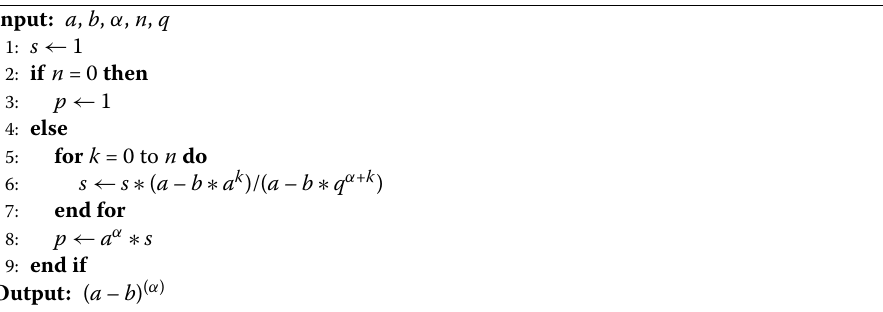
Algorithm 1 The proposed method for calculated ( a – b ) ( α )